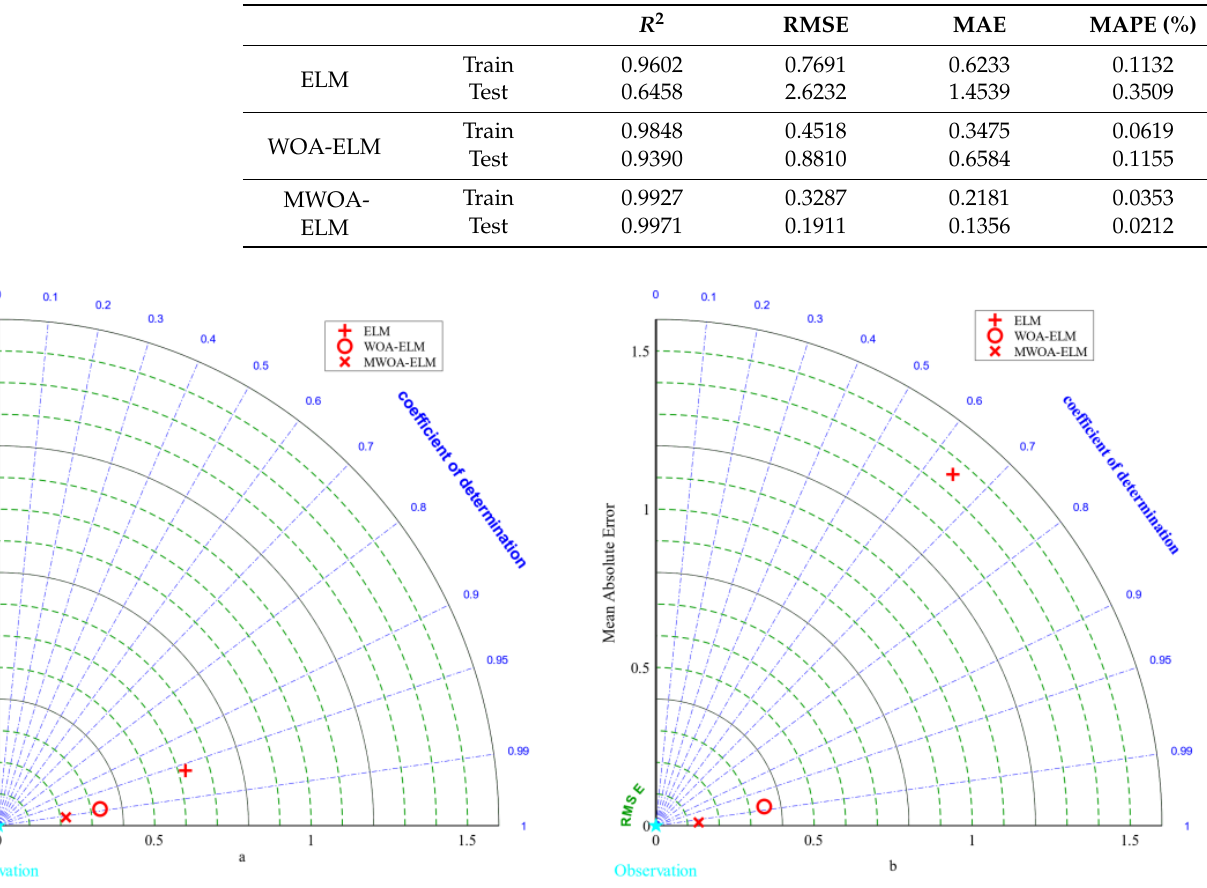
Table 4. Parameter settings for the MWOA-RF